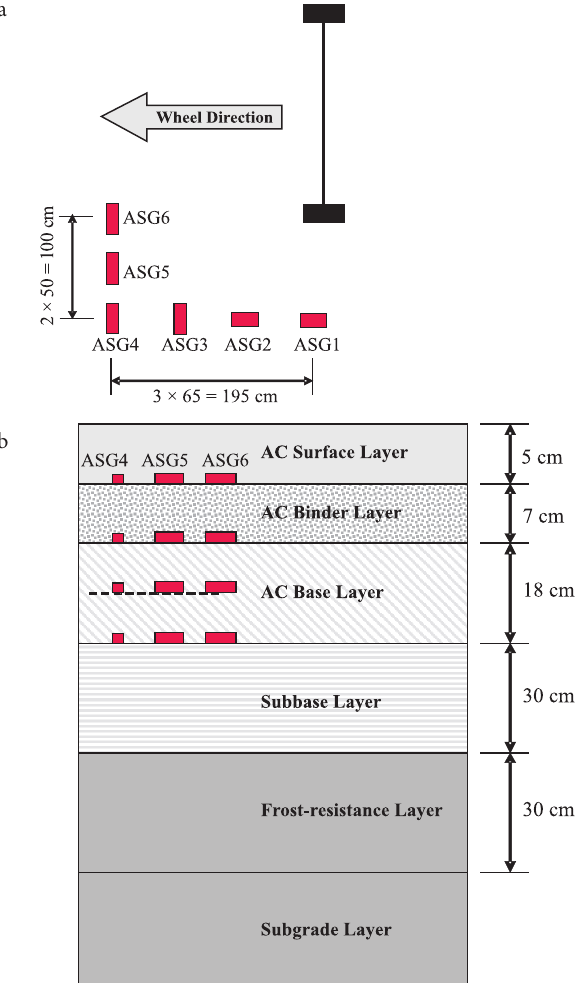
Fig. 1. Test section A5: a – plan view of instrumentation schematic; b – vertical view of strain gauge locations and